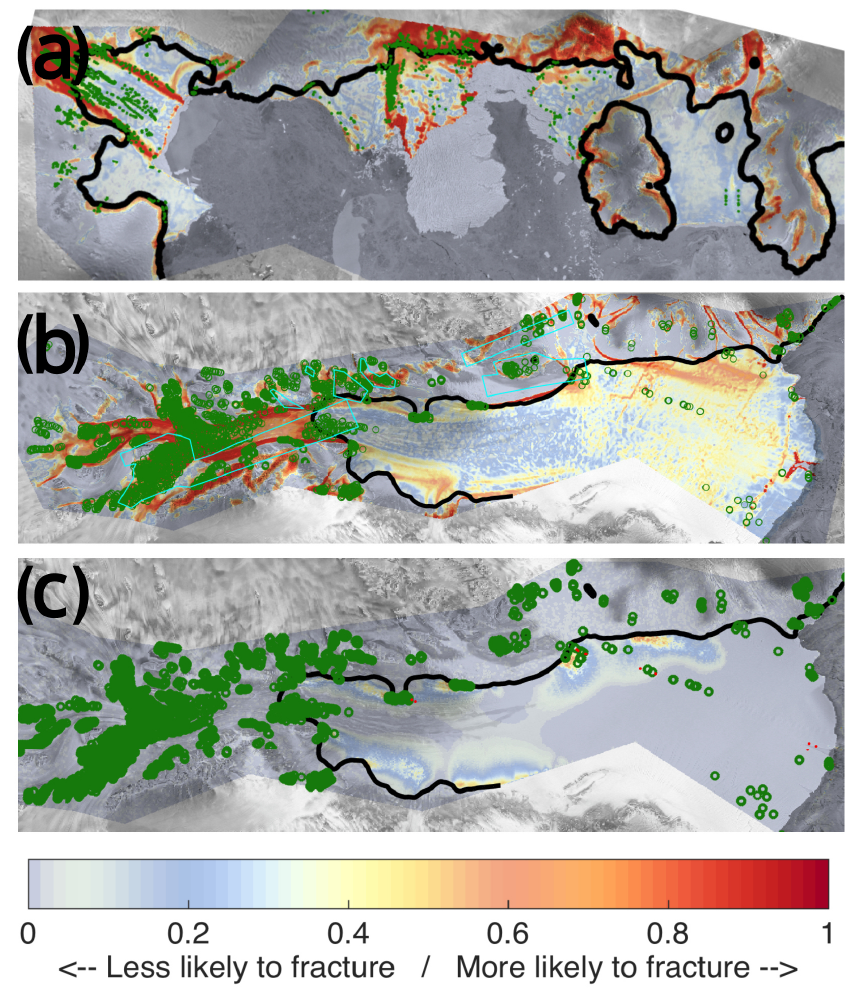
Figure 7. Modelled probability for Pine Island (group 1) (a) , modelled probability for Amery IS (group 4) (b) and inferred damage for Amery (c) . Labels are the same as in Fig. 5. Red dots represent observed fractures that were considered to have advected downstream from areas identified as fracture formation zones by the damage model and, thus, were not used for evaluation of the damage-based